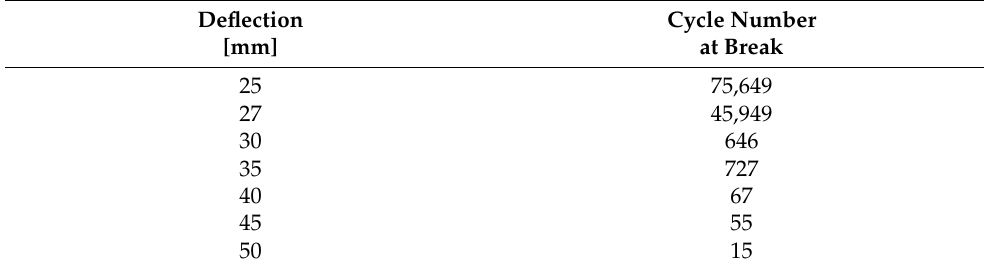
Table 3. The deflection–cycle values of fiberglass